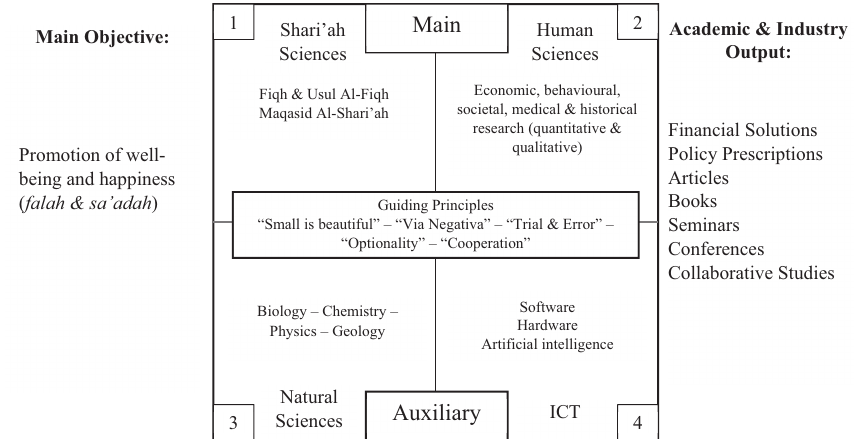
Figure 1. The proposed